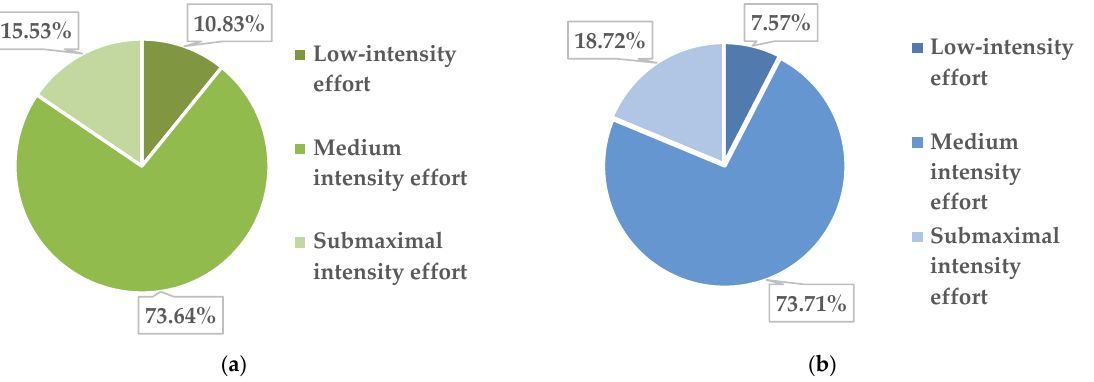
Figure 4. Distribution of physical activity by intensity of the physical effort in obese boys ( a ) and overweight boys ( b ).